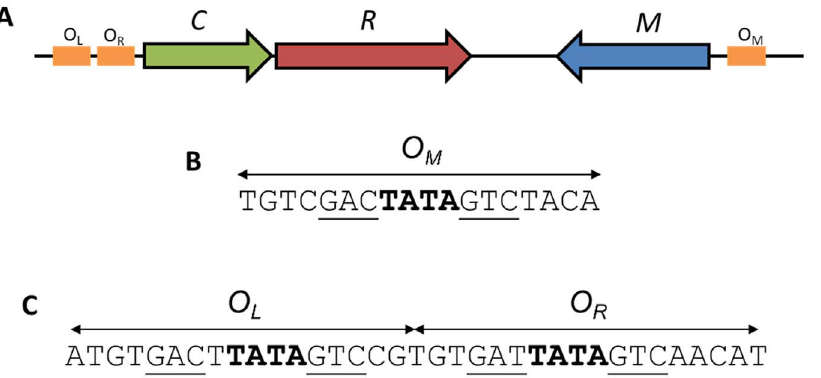
Figure 1. Gene arrangement of the Esp1396I RM system and C.Esp1396I binding sites. (A): The C-protein (C), endonuclease (R) and methyltransferase (M) genes. C/R genes form an operon that is convergent with the M gene. The three C-protein binding sites are shown in orange. (B) The O M operator controls expression of the M gene. (C) The O L and O R operators control the expression of the C/R genes.